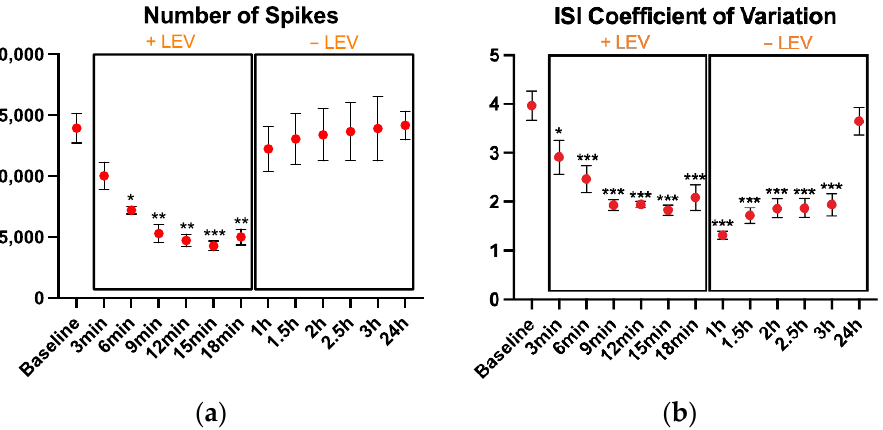
Figure 2. Spiking results: ( a ) the number of spikes, ( b ) coefficient of variation of the inter-spike interval during the 2 min recordings. After the baseline recording, LEV was added to the cell culture and its effects were monitored every 3 min up to 18 min; then, cell medium was replaced to remove LEV and cell activity was monitored every 30 min up to 3 h and finally, one recording was performed at 24 h. The cultures were kept at 37 °C under a 5% CO 2 atmosphere during the recordings. Data are expressed as mean ± SEM of four independent experiments. All comparisons are performed vs. the baseline. * p < 0.05; ** p < 0.01; *** p < 0.001.